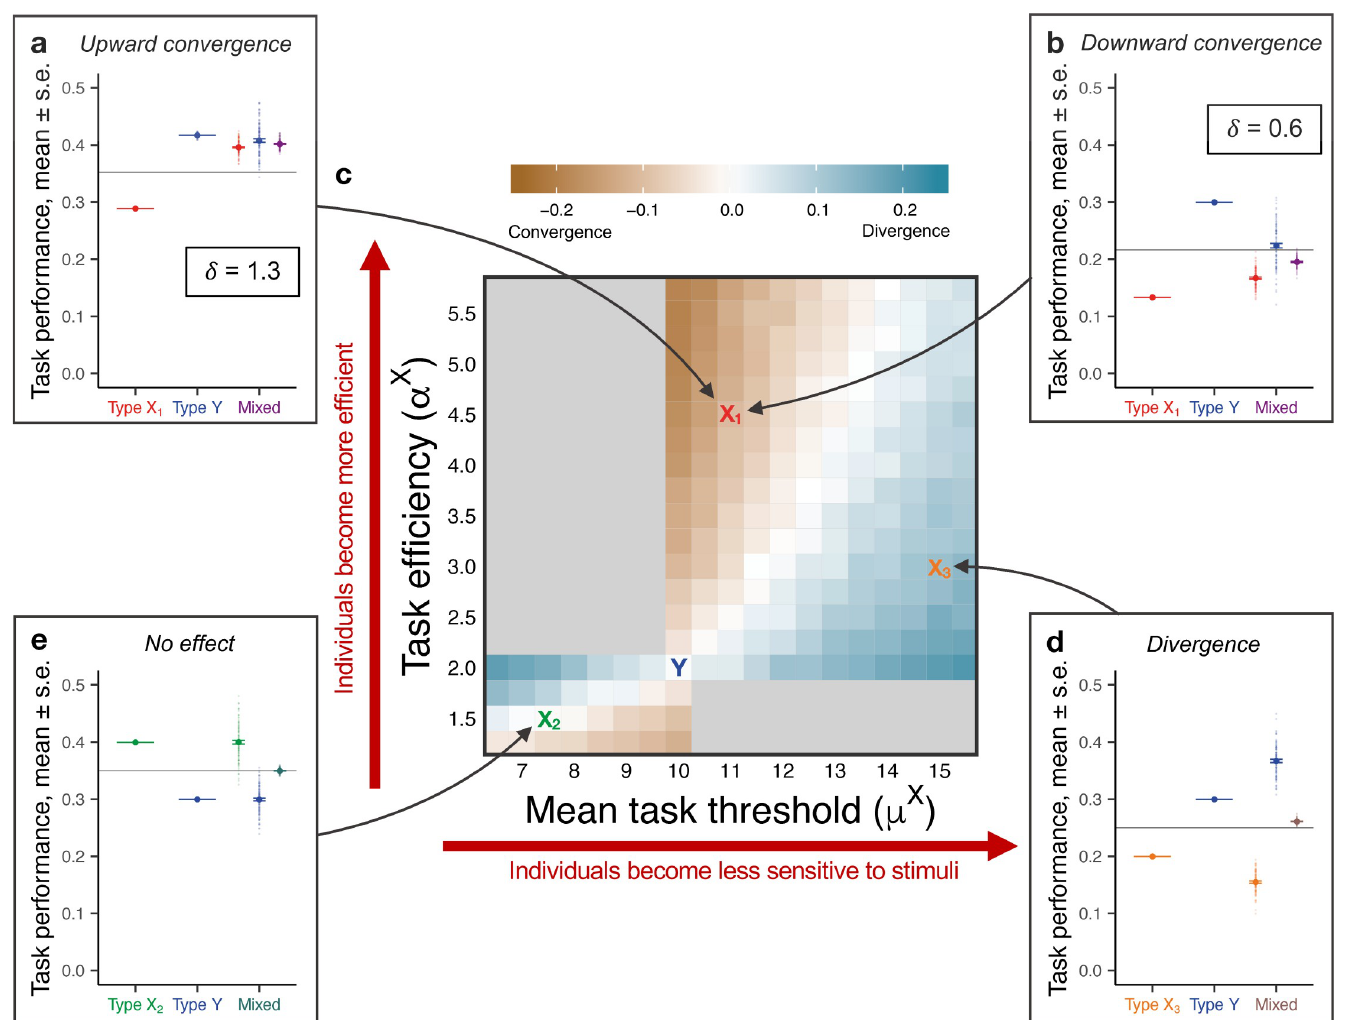
Fig 3. Theoretical predictions of the expanded model. ( a , b , d , and e ) Task performance frequency for a single task as a function of colony composition. Opaque circles represent replicate colonies ( n = 100 replicates per composition); solid circles represent the average across replicates; horizontal bars represent s.e.; and horizontal gray lines represent the average of the pure colonies (first two columns). Identical colors indicate ants of the same type; in particular, type Y ants are the same across all panels ( α Y = 2, μ Y = 10). ( a and b ) Differences in both task efficiency and mean threshold ( α X 1 = 4.5, μ X 1 = 11) capture asymmetric behavioral convergence, with directionality determined by the demand rate: ( a ) upward ( δ = 1.3) and ( b ) downward ( δ = 0.6). ( d and e ) Differences in both task efficiency and mean threshold capture both ( d ) behavioral divergence ( α X 3 = 3, μ X 3 = 15) and ( e ) a lack of effects from mixing ( α X 2 = 1.5, μ X 2 = 7.5). ( c ) Change in relative task performance between mixed and pure colonies (measured as (Y m -X m )-(Y p -X p )) as a function of type X’s efficiency and mean threshold ( n = 50 replicates per parameter combination). Types X 1 , X 2 , X 3 , and Y correspond to those in a , b , d , and e . Blue gradient indicates behavioral divergence (Y m -X m > Y p -X p ); brown gradient indicates convergence (Y m -X m < Y p -X p ); and light gray indicates regions with behavioral patterns falling outside our definitions (see Materials and methods). See S1 Table for other parameter values. Simulation code and data are available at https://github.com/marikawakatsu/mixing-model.